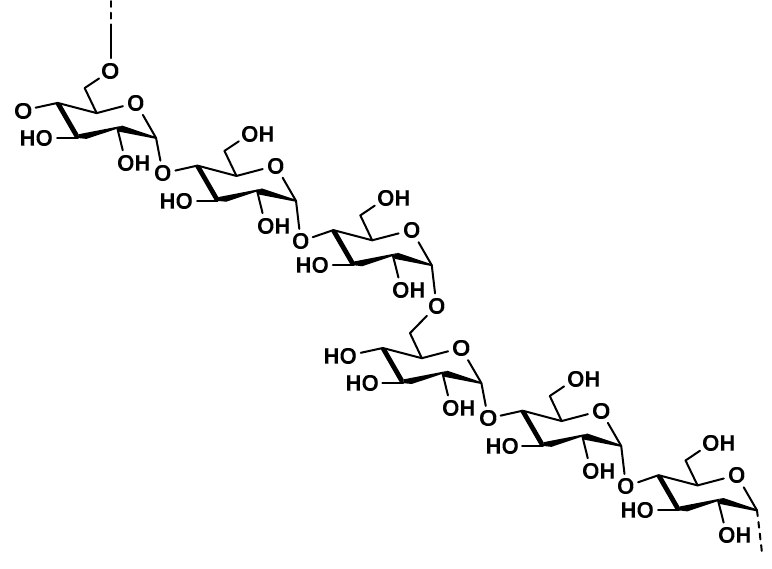
Figure 10. Chemical structure of pullulan.